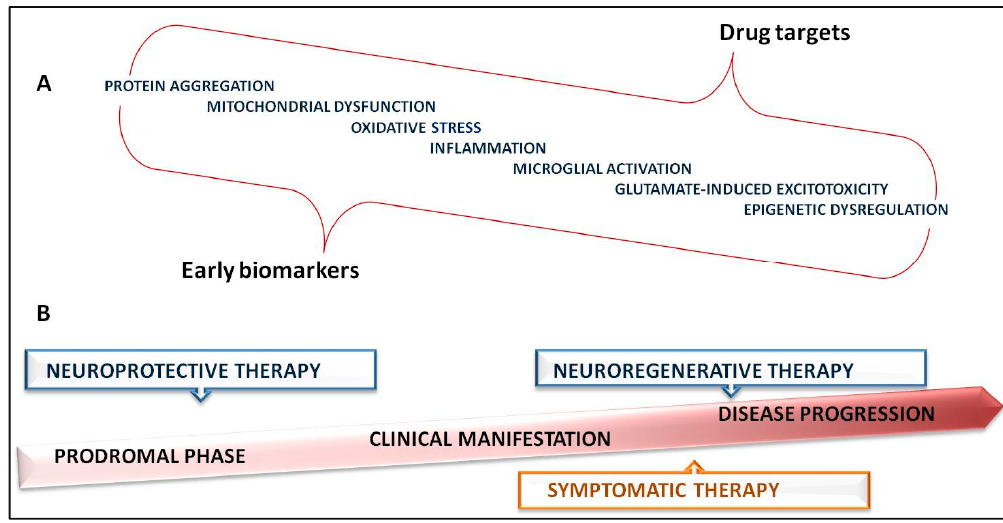
Figure 2. Complex nature of ALS pathogenesis and therapy strategies. ( A )—“ALS mega-pathway”: pathogenic mechanisms crucial for biomarkers and drug targets identification; ( B )—therapeutic possibilities